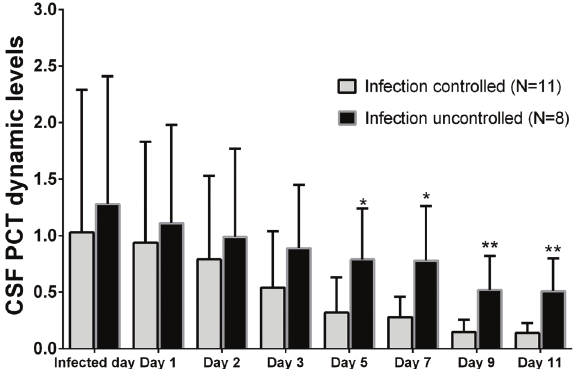
Figure 2. Dynamic culture of cerebrospinal fl uid (CSF) procalci- tonin (PCT) levels in infection-controlled group and